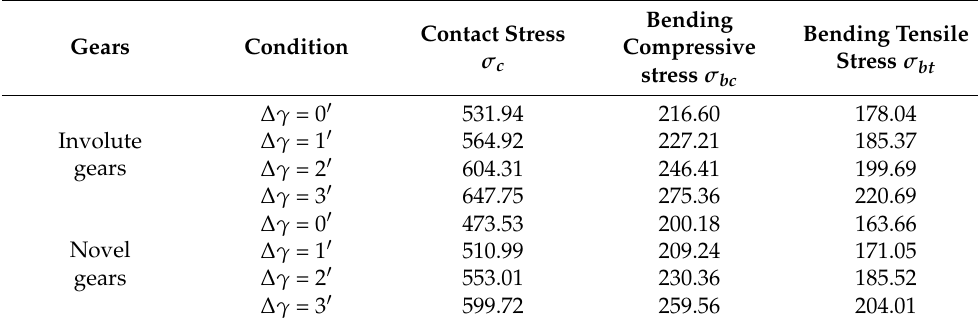
Table 5. Comparison of maximum stress between modified novel gears and modified involute gears with different misalignment errors